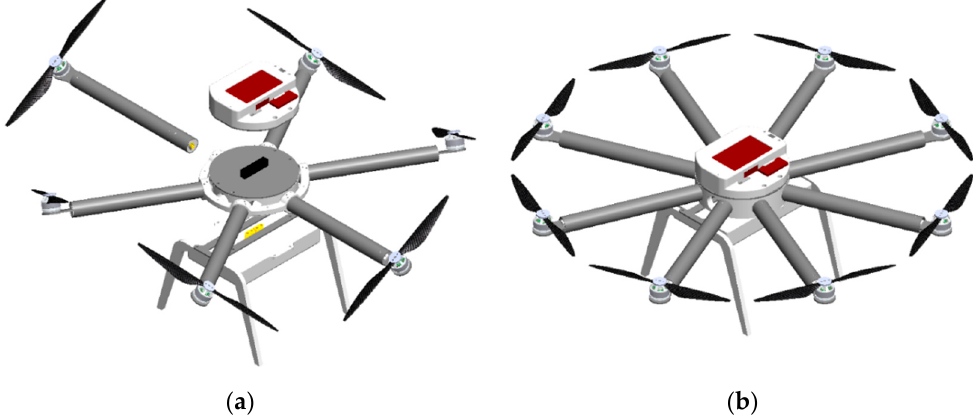
Figure 12. Multirotor configurations 3D models: ( a ) non-flat hexarotor X (NFX6); ( b ) flat octorotor X (FX8).